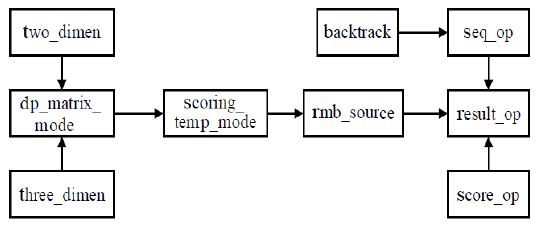
Fig. 5 LCS component dependency